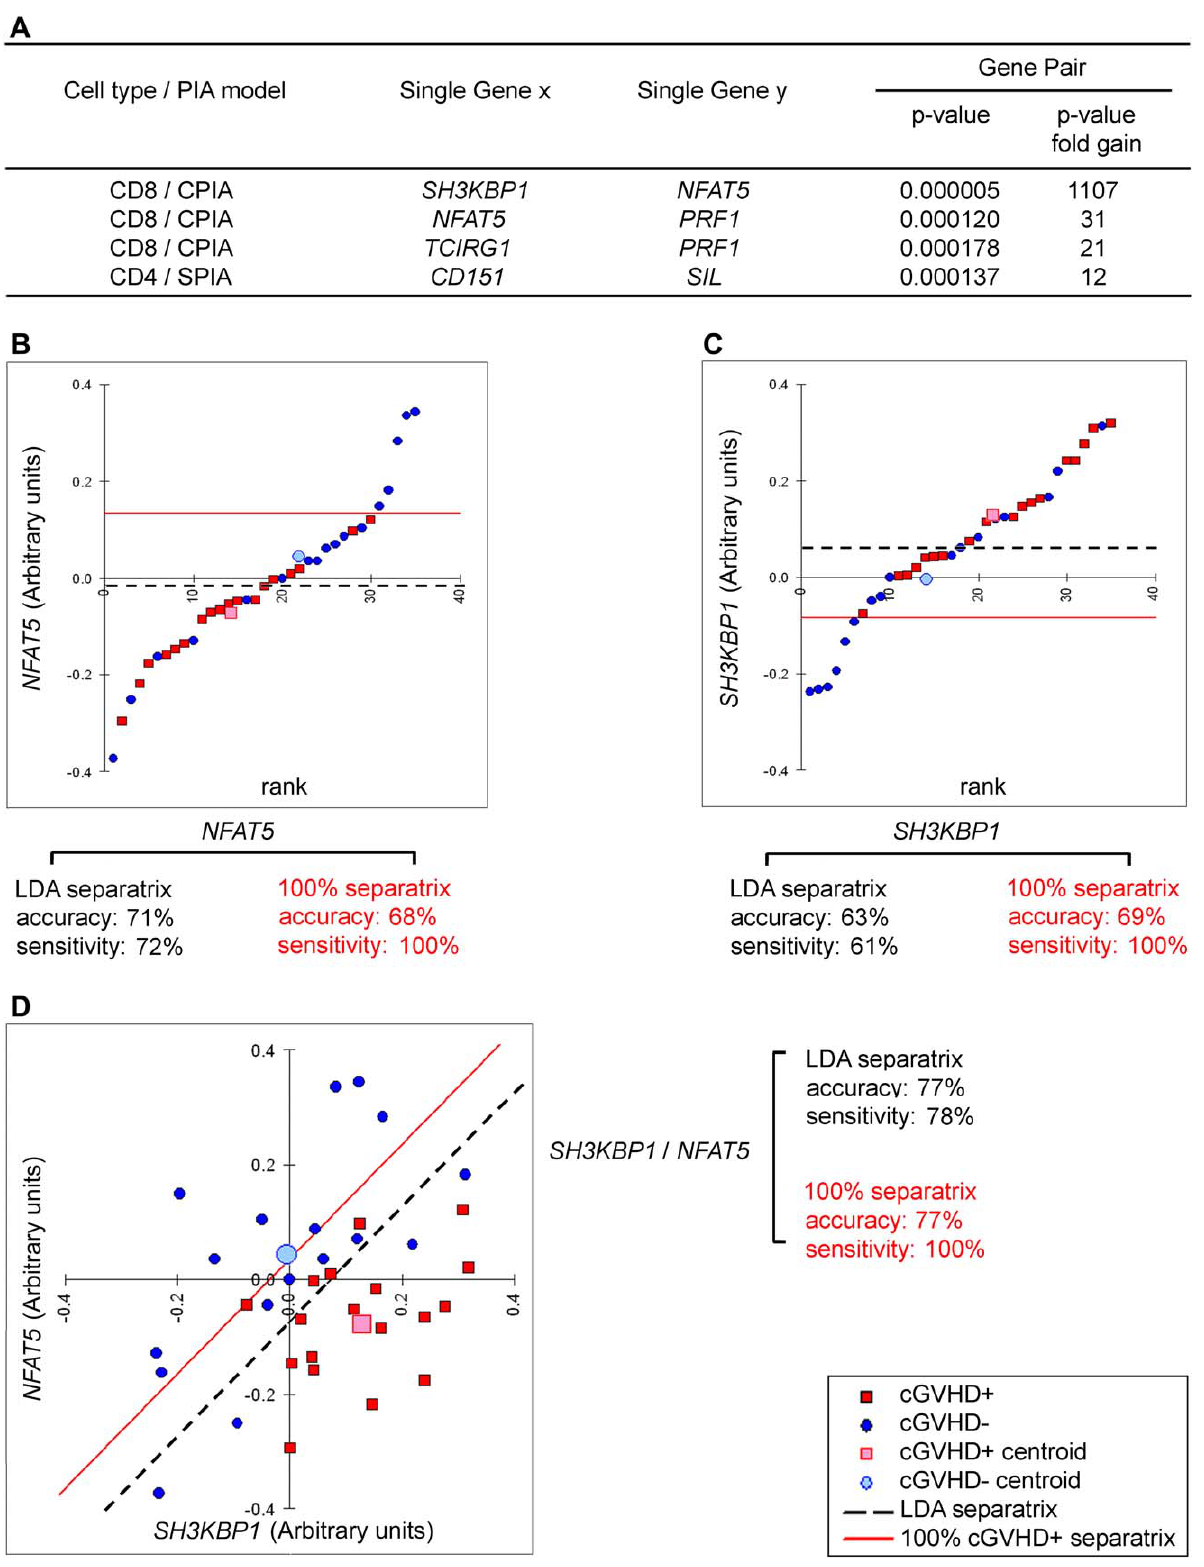
Figure 4. Competitive and Synergistic Interactions between GVHD-Predictive Genes (A) PIA identified four gene pairs whose p -value for cGVHD prediction was at least 10-fold lower than that of constituent genes. LDA-based scatterplots of qRT-PCR data for (B) NFAT5, (C) SH3KBP1, and (D) the NFAT5/SH3KBP1 gene pair. Dotted lines represent LDA-generated separatrices. Red lines correspond to 100% cGVHD þ separatrices (designed to maximize sensitivity).